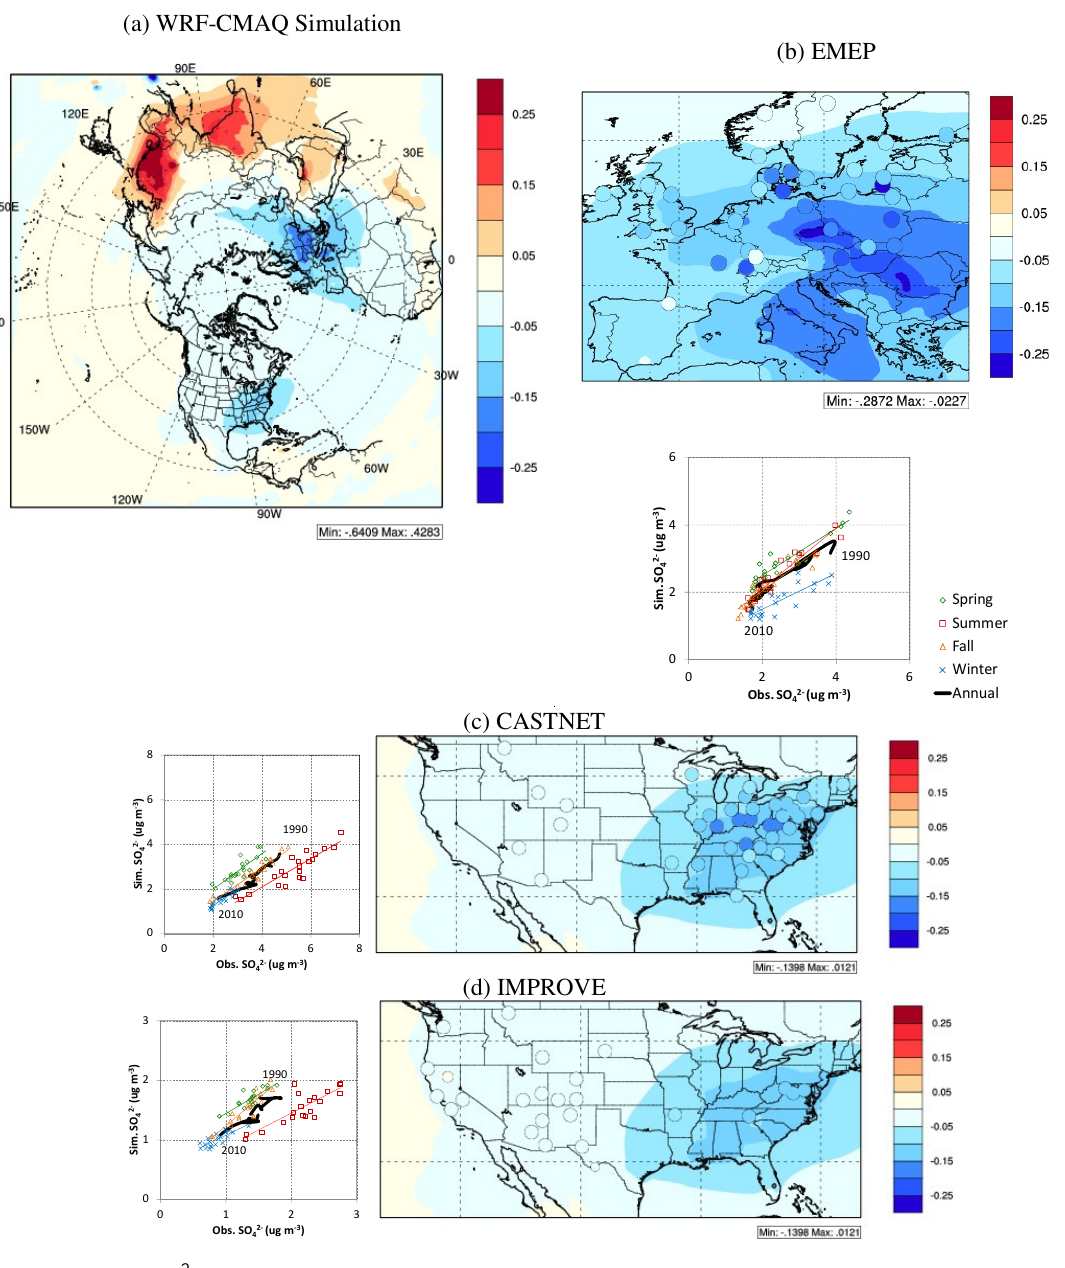
Figure 6. Same as Fig. 3 for SO 2 −